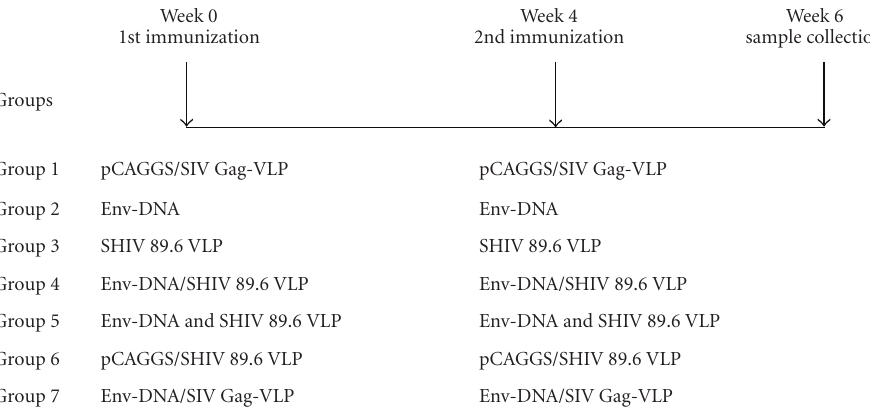
Figure 2: Schematic diagram of immunization study design. Six groups of mice (groups of 6) were immunized with di ff erent vaccine preparations as indicated. Group 1: a mixture of 50 μ g DNA vector pCAGGS and 50 μ g SIV Gag-VLPs; Group 2: 50 μ g HIV Env-DNA; Group 3: 50 μ g SHIV 89.6 VLPs; Group 4: a mixture of 50 μ g HIV Env-DNA and 50 μ g SHIV 89.6 VLPs; Group 5: simultaneous injection with 50 μ g HIV Env-DNA and 50 μ g SHIV 89.6 VLPs at separate sites; Group 6: a mixture of 50 μ g pCAGGS DNA vector and 50 μ g SHIV 89.6 VLPs; Group 7: a mixture of 50 μ g HIV Env-DNA and 50 μ g SIV Gag-VLPs. Mice were immunized twice by intramuscular